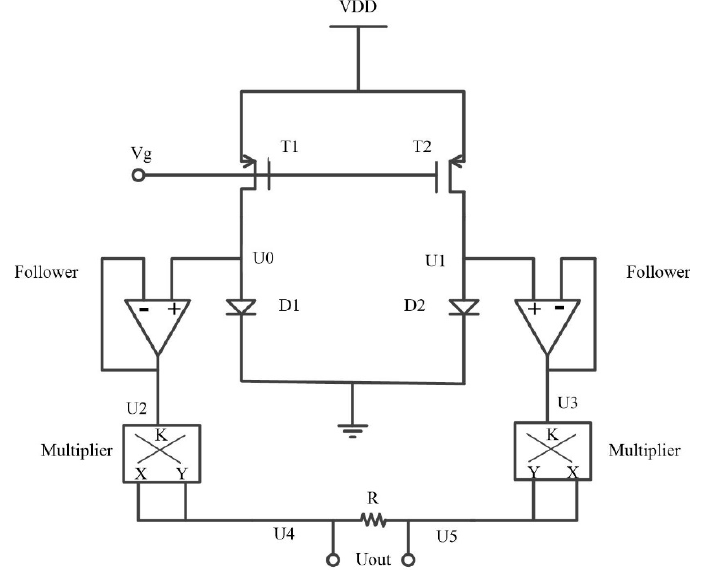
Figure 5. Schematic of the proposed PTAT circuitry.